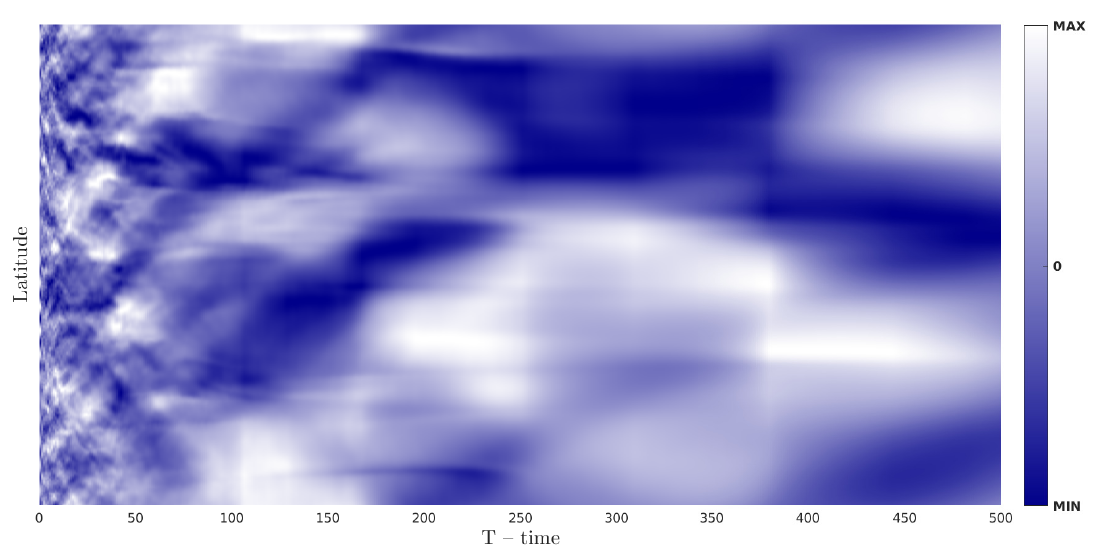
Figure 4. Latitude-time maps of the zonal velocity V x ( y ) averaged over the zonal direction for two-dimensional decaying MHD turbulence. Color varies from white corresponding to the maximum value of the function V x ( y ) to blue corresponding to the minimum